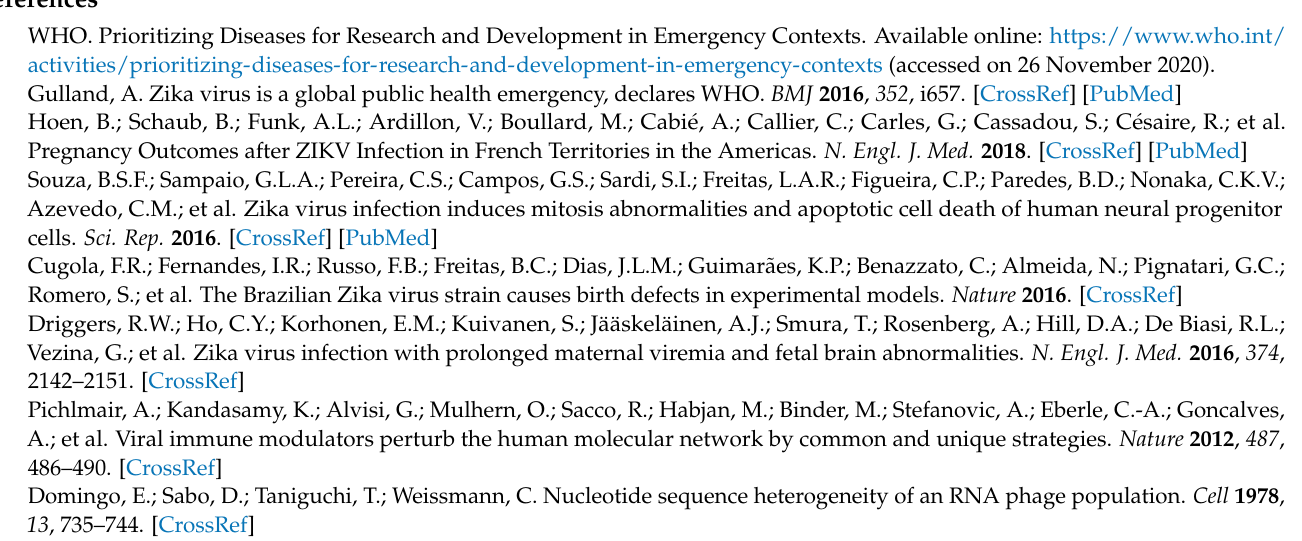
Figure S3: Establishing a human iPS-cell derived cerebral organoid model to study antiviral activity of TH6744, Figure S4: TH6744 has an antiviral effect in human iPS-cell derived cerebral organoid model, Figure S5: Studying ZIKV kinetics and TH6744 time-of-addition. Supplementary Mate- rial and methods: Synthesis of N-(4-iodophenyl)-4-[2-oxo-5-(trifluoromethyl)-2,3-dihydro-1H-1,3- Table S3: DNA Dyes, Supplementary